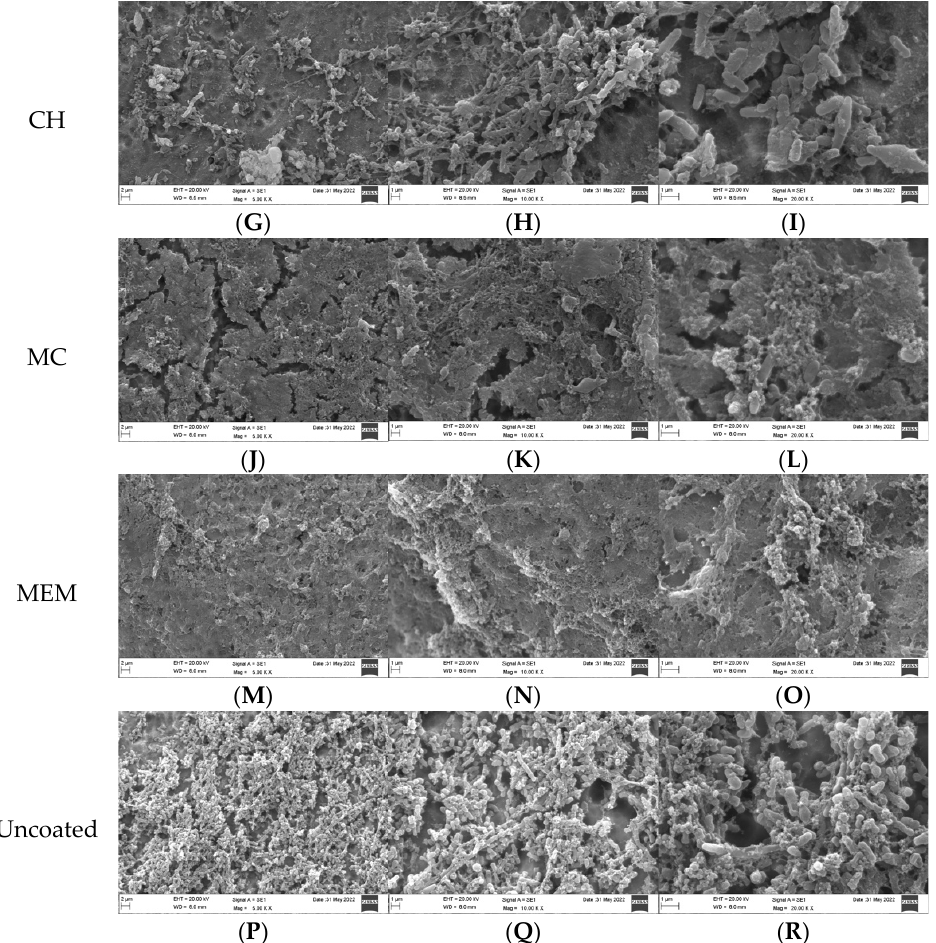
Figure 3. SEM appearance of coated plates with PA bacteria including the negative control at 5, 10, and 20 k magnification.